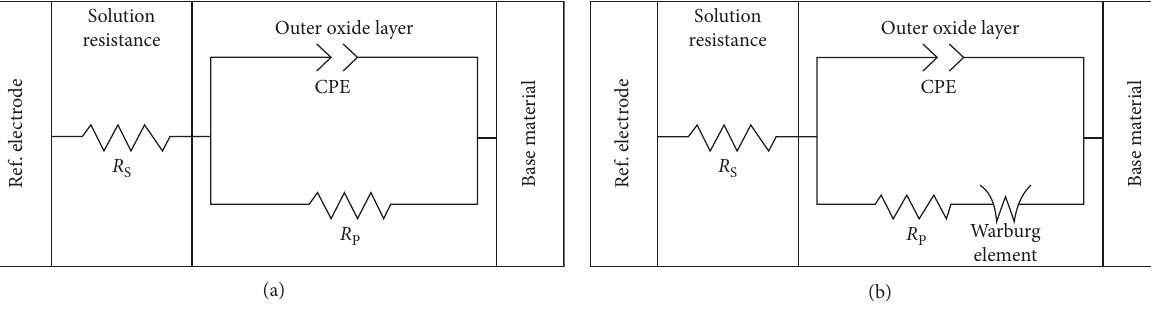
Figure 9: Equivalent electrical circuit (a) used for fitting experimental data of alloy SS316, while circuit (b) was used for A35, A36, and C-276 alloys. R s is the resistance of the electrolyte solution, R p is the oxide layer resistance, and CPE accounts for a nonideal capacitor. Table 3: Electrochemical parameters for A35, A36, C-276, and SS316 alloys in 3.5wt.% NaCl solution at 25 ° C.